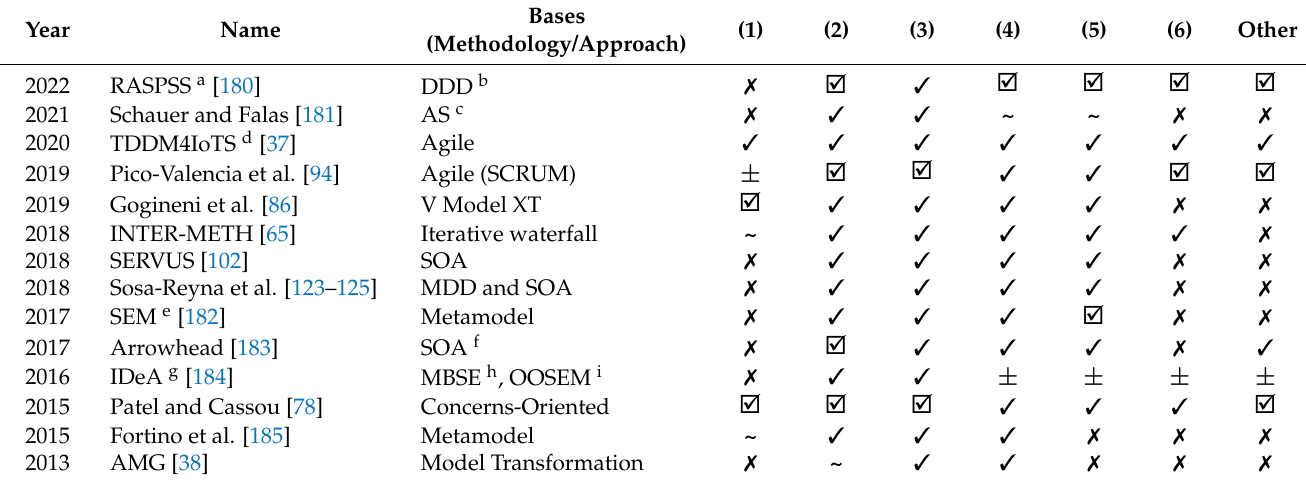
Table 3. Methodologies specifying the stages of the life cycle.